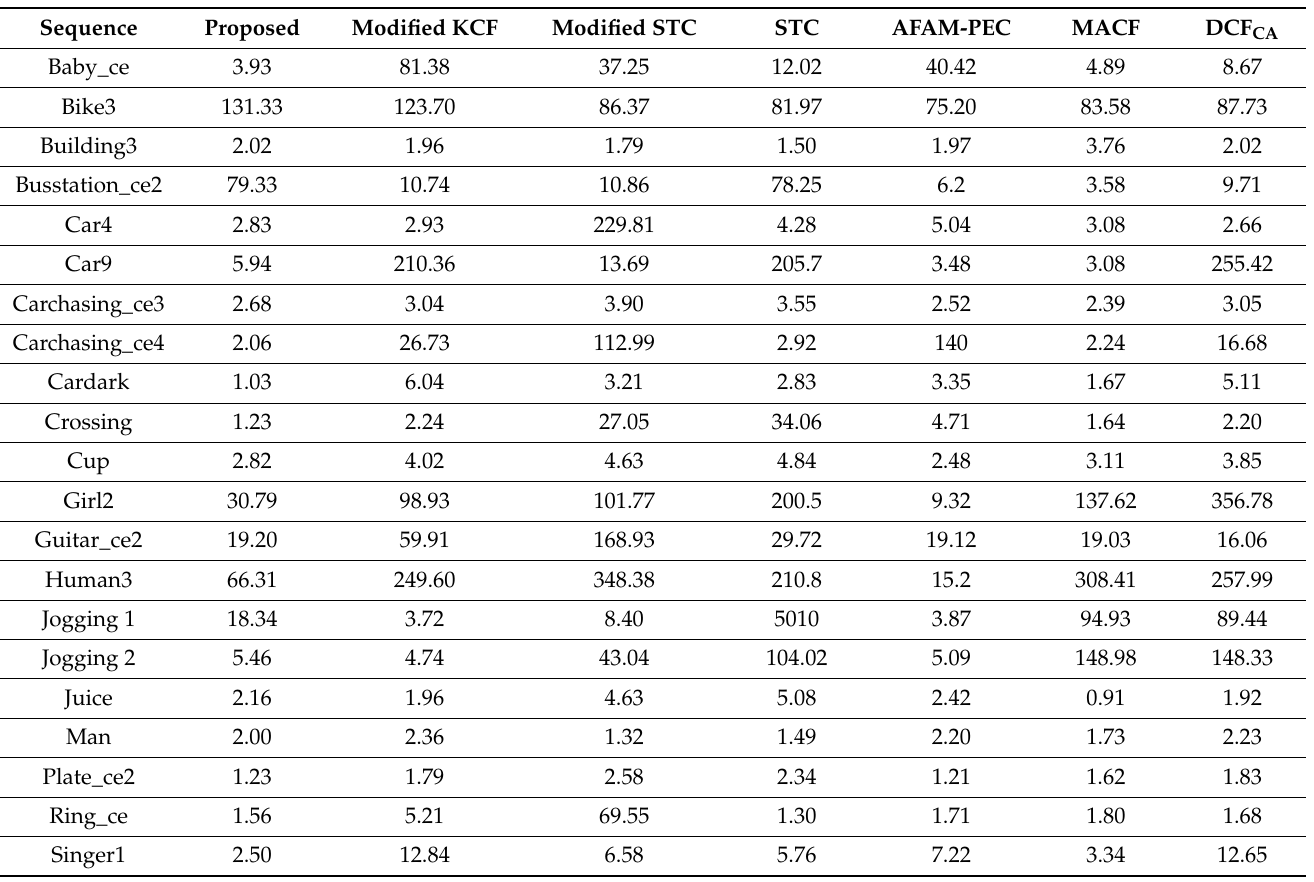
Table 3. Average center location